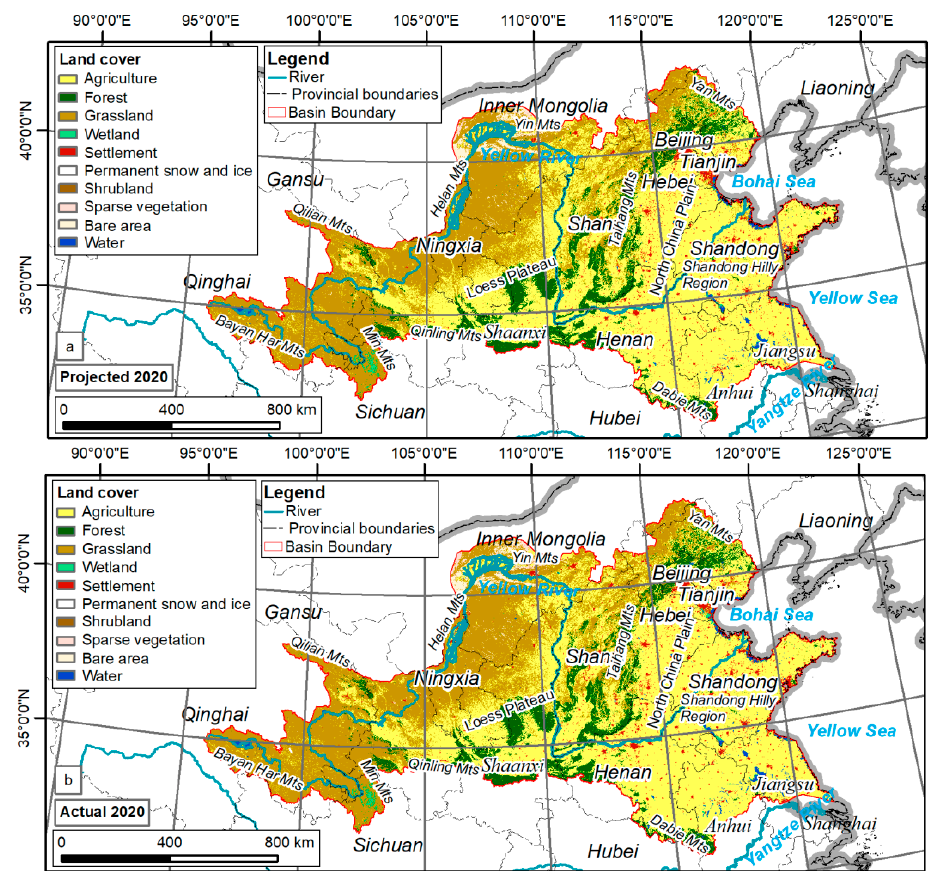
Figure 8. Actual and projected land cover in 2020. ( a ) Projected land cover in 2020; ( b ) actual land cover in 2020. We know that the more similar the two above maps are, the better the simulation results will be. However, there are still some subtle differences between the two maps. For example, the expansion trend of the simulated settlements was still conservative compared with that of the real settlements, and the real settlements expanded more rapidly, for example, in cities in Henan